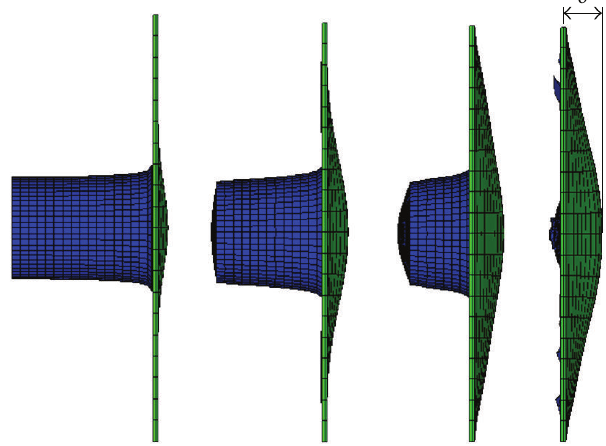
Figure 5: Bird impact on flexible aluminum